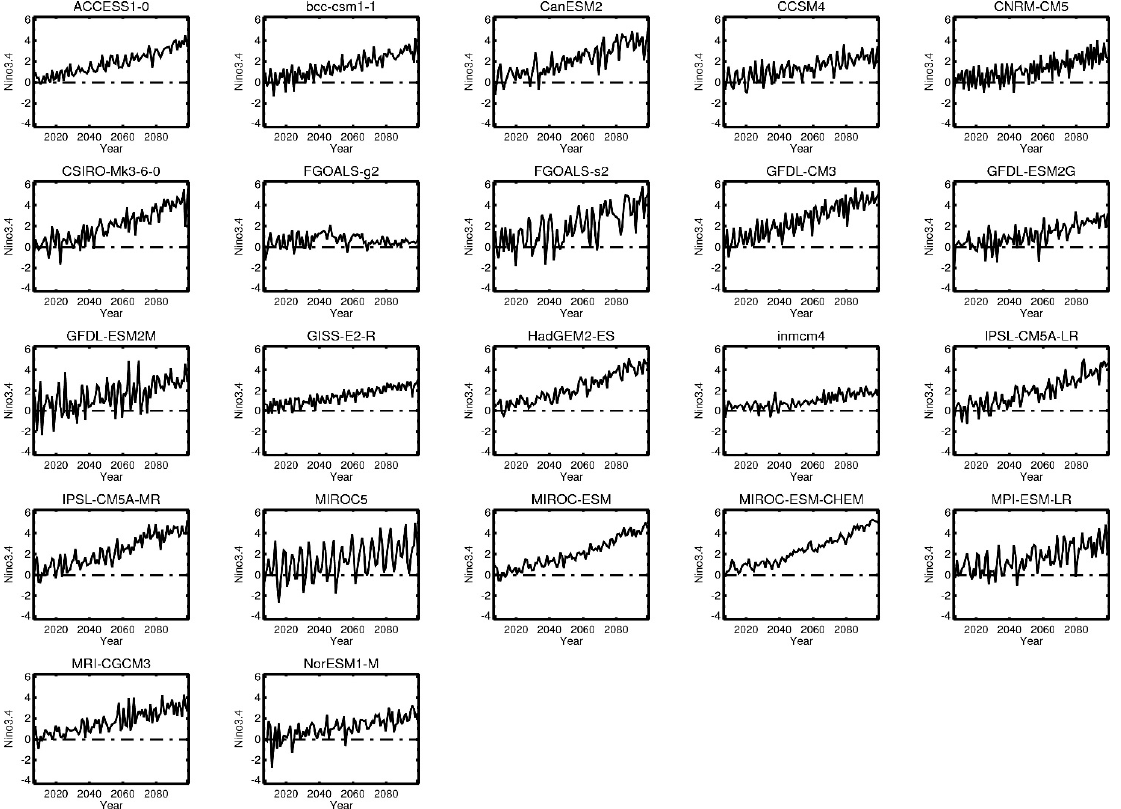
Figure 5. Niño 3.4 time series for various CMIP5 model output during June-July-August-September (JJAS) for the RCP scenario; anomaly calculated relative to a period